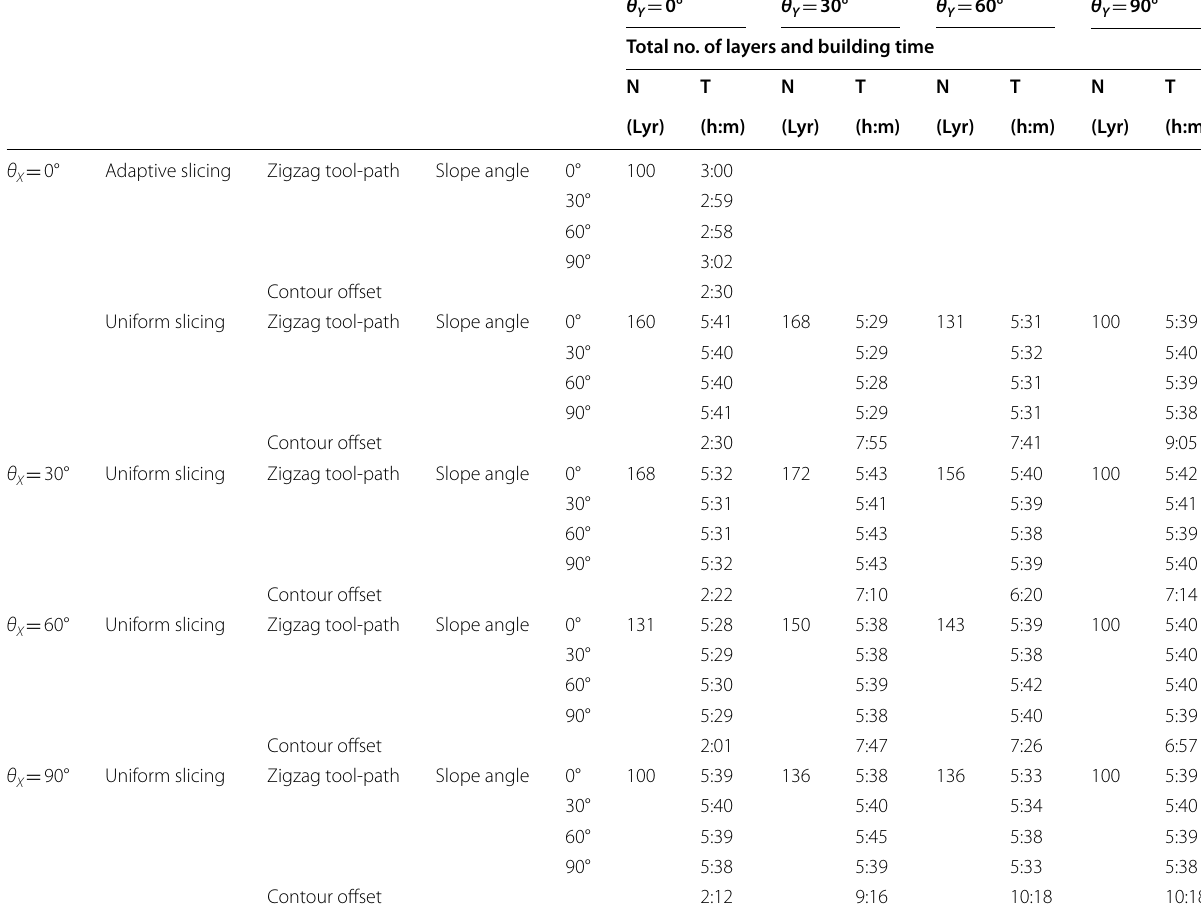
Table 1 Evaluation of building time criteria in the case study no.1